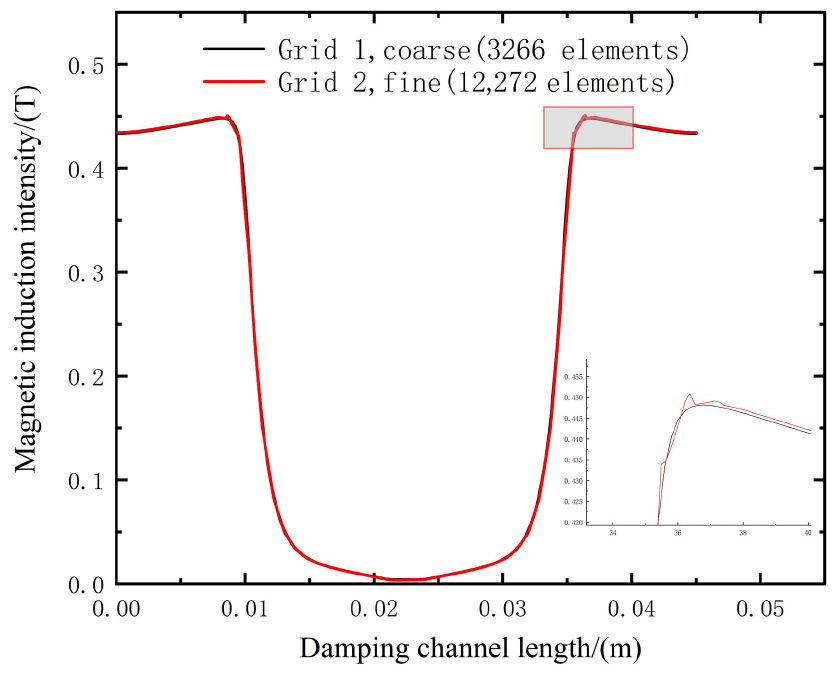
Figure 5. Grid independence analysis of the current FE model.